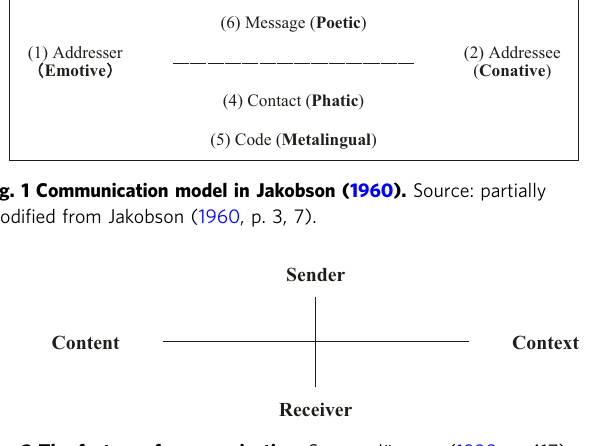
Fig. 2 The factors of communication. Source: Jönsson (1998, p.